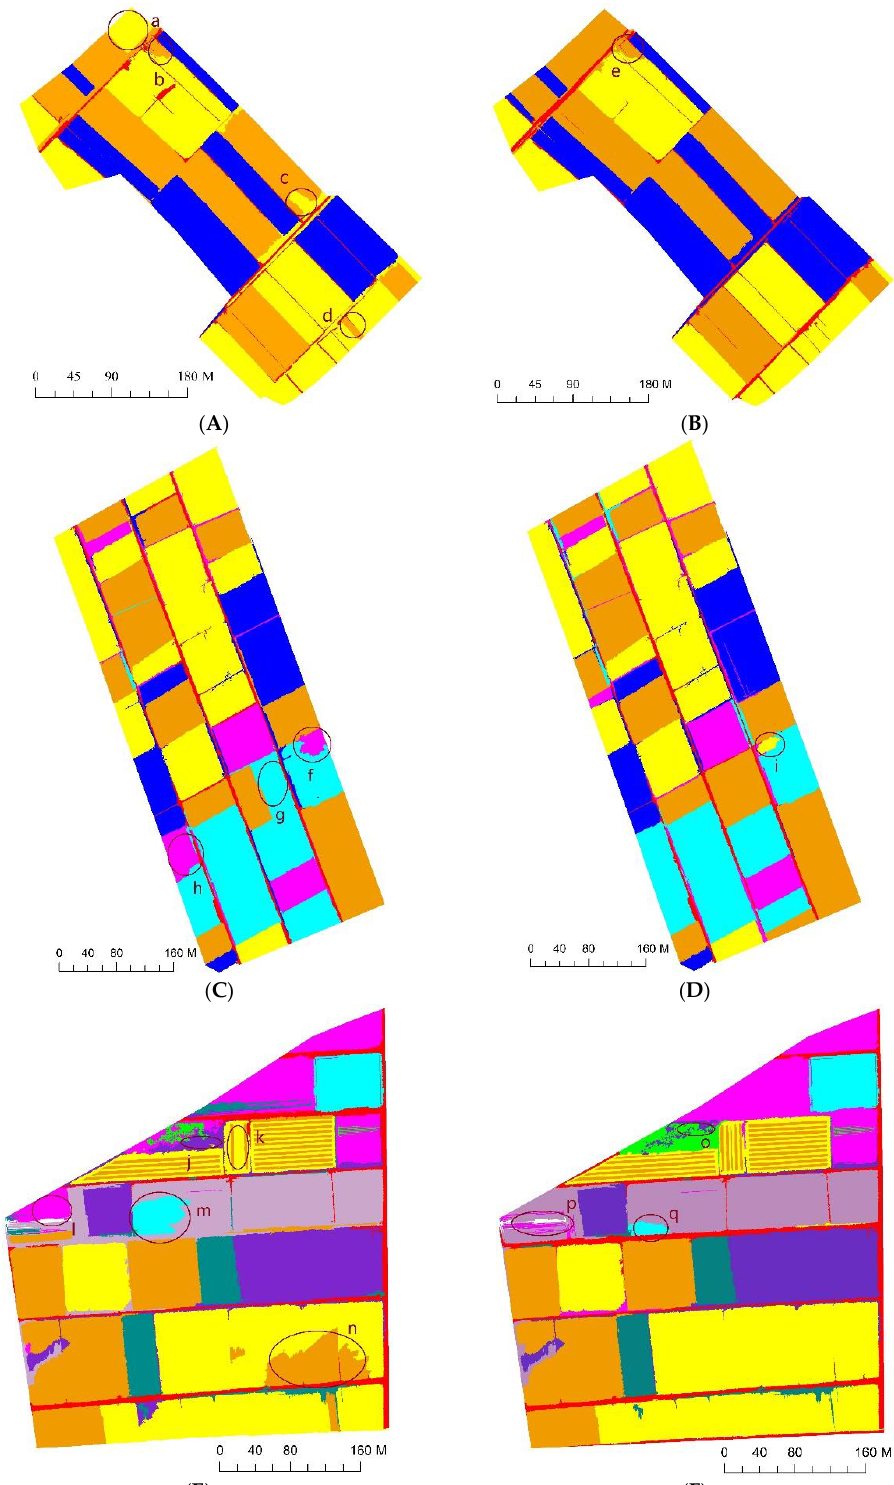
Figure 9. Classification error map of OB-RF and OB-SVM in study areas. (( A ) classification error map of OB-RF in study area 1; ( B ) classification error map of OB-SVM in study area 1; ( C ) classification error map of OB-RF in study area 2; ( D ) classification error map of OB-SVM in study area 2; ( E ), classification error map of OB-RF in study area 3; ( F ) classification error map of OB-SVM in study area 3.)